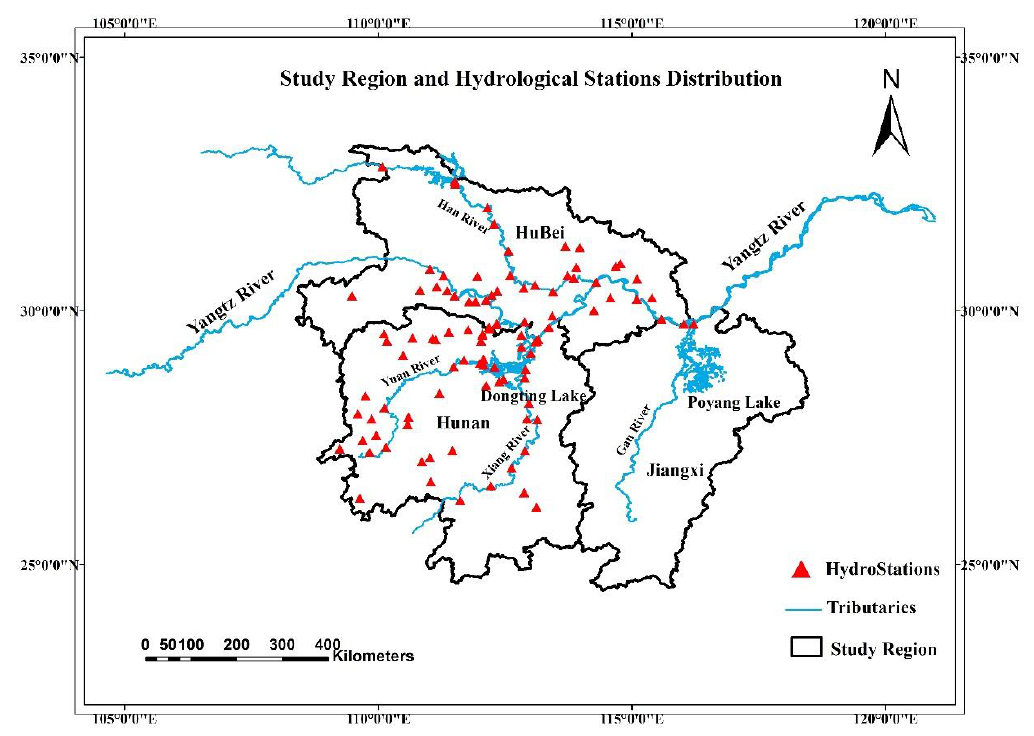
Figure 1. Study region and hydrological stations.